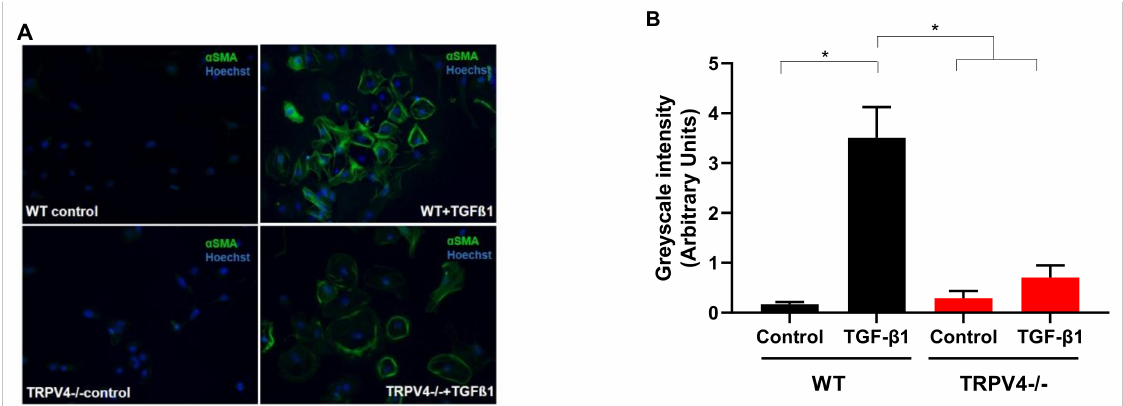
Figure 3. Epithelial mesenchymal transition (EMT) of primary alveolar epithelial cells type 2 (AT2) after application of TGF- β 1 quantified by immunostaining of α -smooth muscle actin ( α -SMA) and cell nuclei with Hoechst dye (Hoechst). ( A ) Pictures of representative immunohistochemistry stainings of AT2 cells from wild-type (WT) and TRPV4-deficient (TRPV4-/-) mice by a fluorescence-coupled anti- α -SMA antibody (described in Reference [110]) after application of TGF- β 1 (+TGF- β 1) or solvent (control). ( B ) Summary of data. Grey values of AT2 cells from wild-type (WT) and TRPV4-deficient (TRPV4-/-) mice are plotted. Data are shown as means with standard errors of the mean (SEM) of three independent cell isolations (described in Reference [109]). * indicates a p -value of